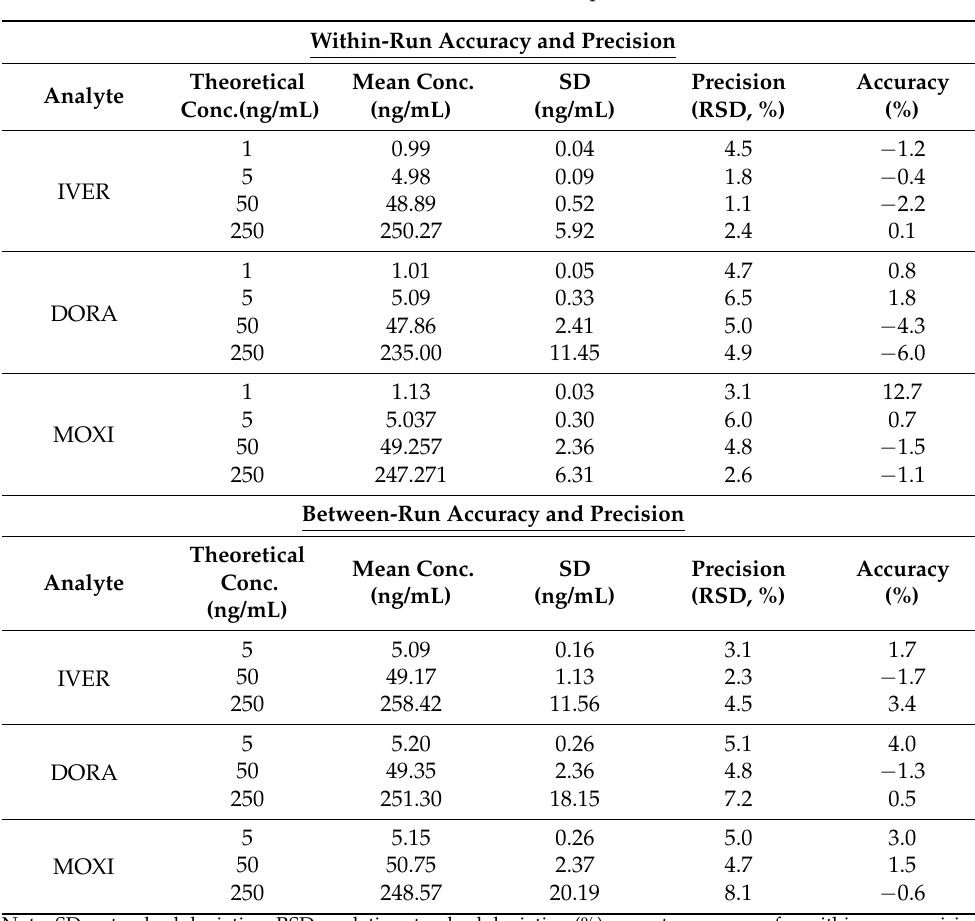
Table 3. Validation results for within-day and between-day precision and accuracy of ivermectin (IVER), doramectin (DORA), moxidectin (MOXI) in bovine plasma. Within-Run Accuracy and Precision Analyte